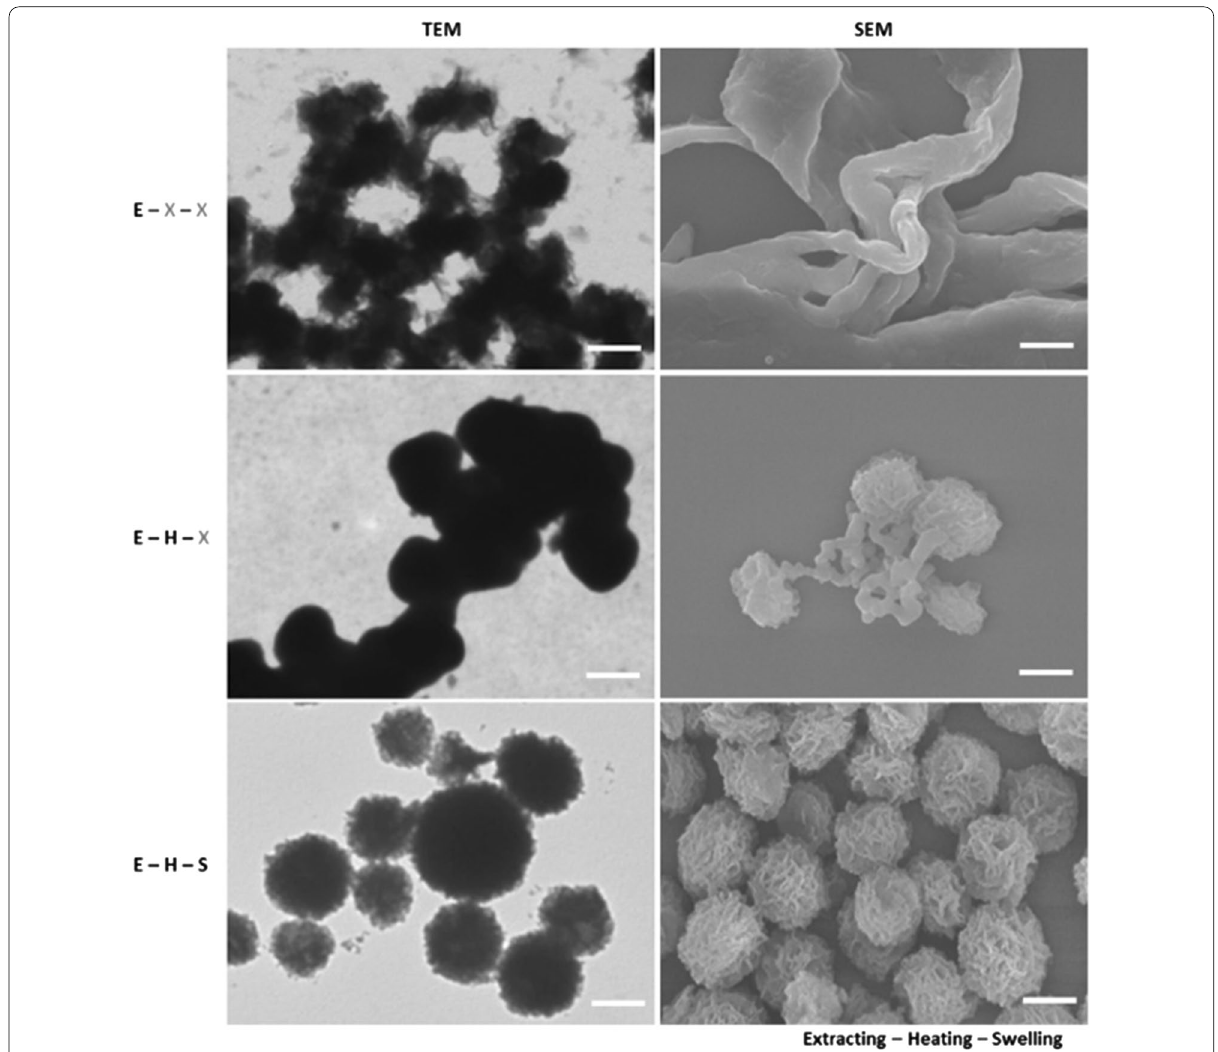
Fig. 2 Morphology of PANS via transmission electron microscopic (TEM, left) and scanning electron microscopic (SEM, right) imaging. Alphabetic characters represent sequential synthetic processes of PANS; (E): extracting reactant with BE, (H): heating sequentially the reactant at 200 °C and 300 °C, and (S): swelling the reactant using EtOH. Note that (X): no treatment. Scale bars are 500